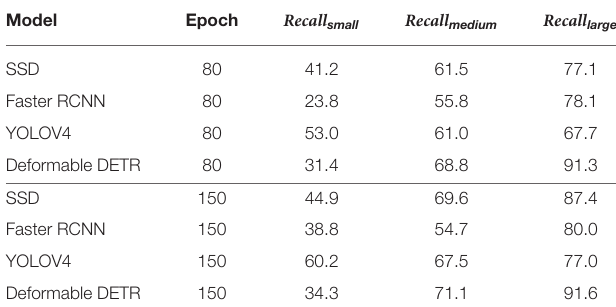
TABLE 7 | mAP multi − scale values of multi-scale results achieved by different models on Forestry Pest Dataset. Model